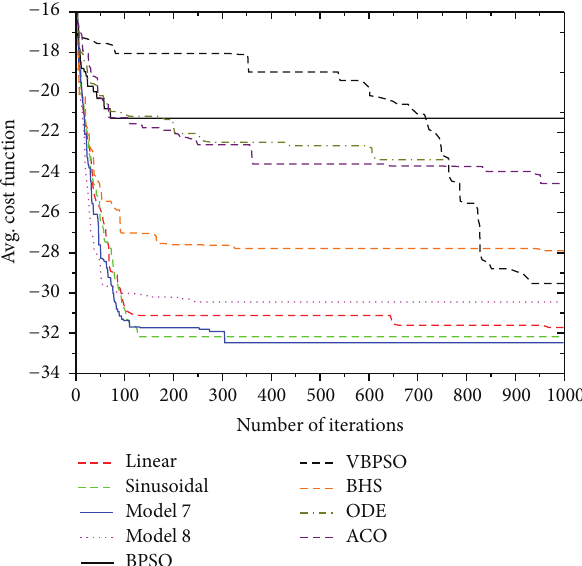
Figure 7: Convergence rate graph for the 300-element asymmetric thinned array with same aperture size.